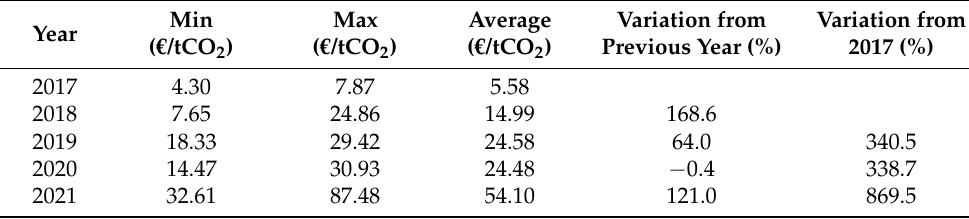
Figure 6. Annual EEX Emissions CO 2 market price (min, max and average price in EUR). Table 5. EEX Emissions CO 2 market price for years 2017–2021 in EUR/tCO 2 [25].